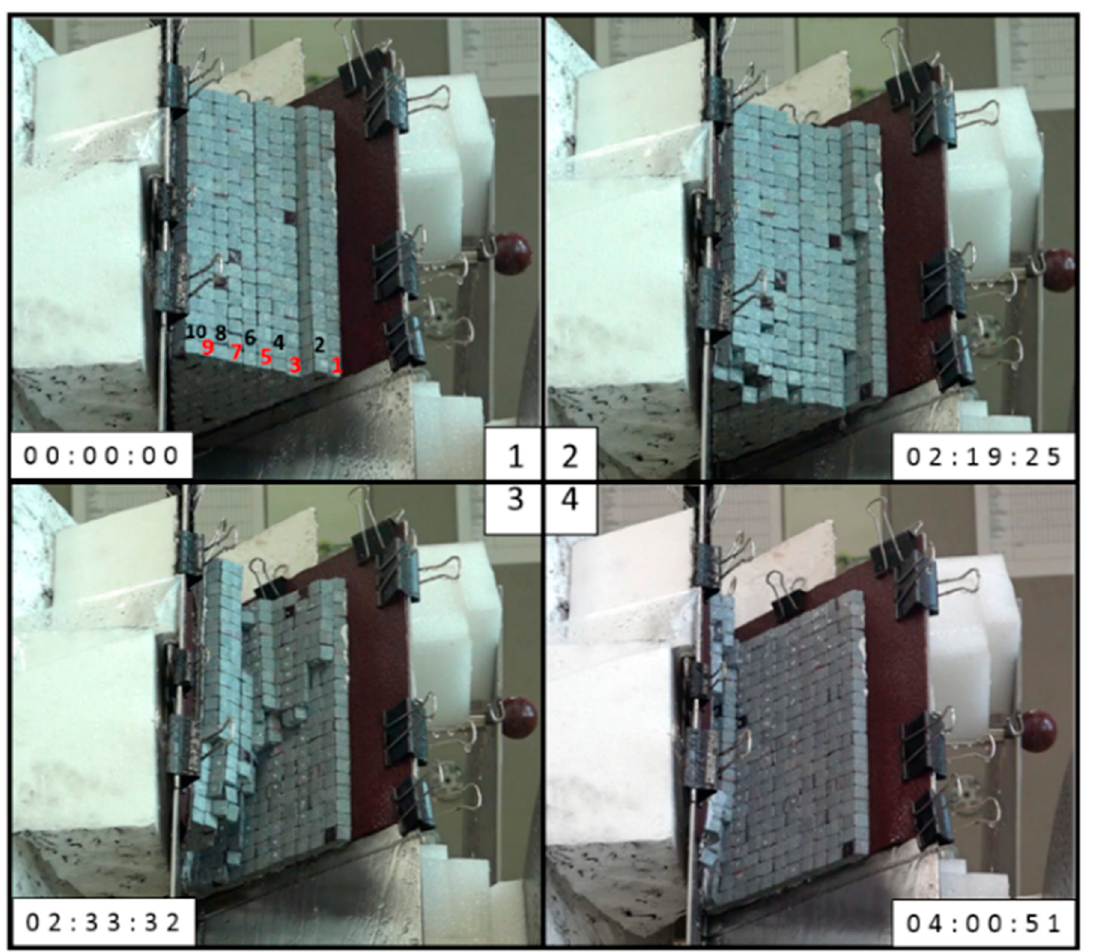
Figure 12. Physical Model G ( i a = 60°, ω 1 = 40° and ω 2 = 10°).